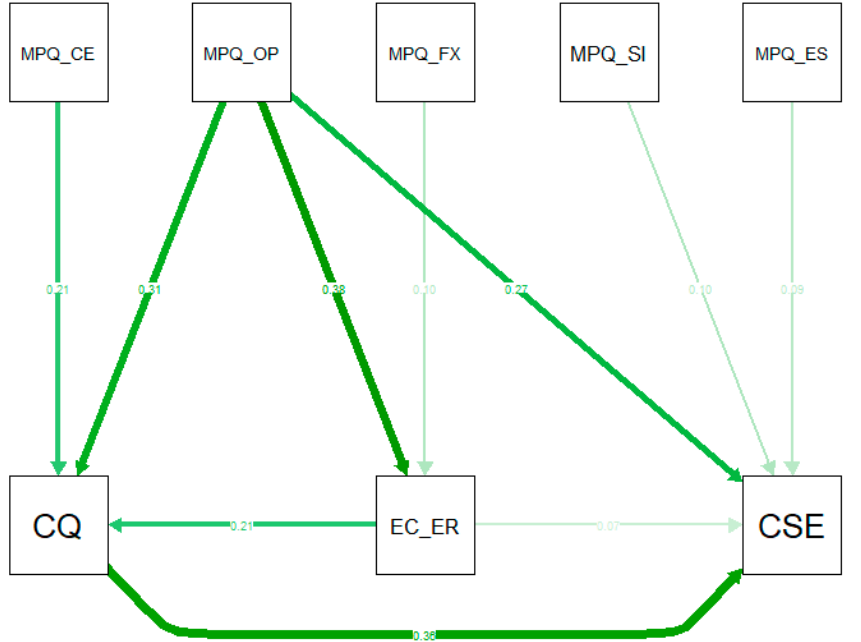
Figure 2. Graphical representation of Model 2. Note: MPQ = multicultural personality questionnaire, CE = cultural empathy, FX = flexibility, SI = social initiative, ES = emotional stability, OP = open mindedness, EC_ER = ethnocentric–ethnorelative continuum, CQ = cultural intelligence, CSE = cultural self-efficacy, US = understanding, LAN = language. All reported relationships have positive and significant effects of at least p < 0.05. Table 3. Regressions from Model